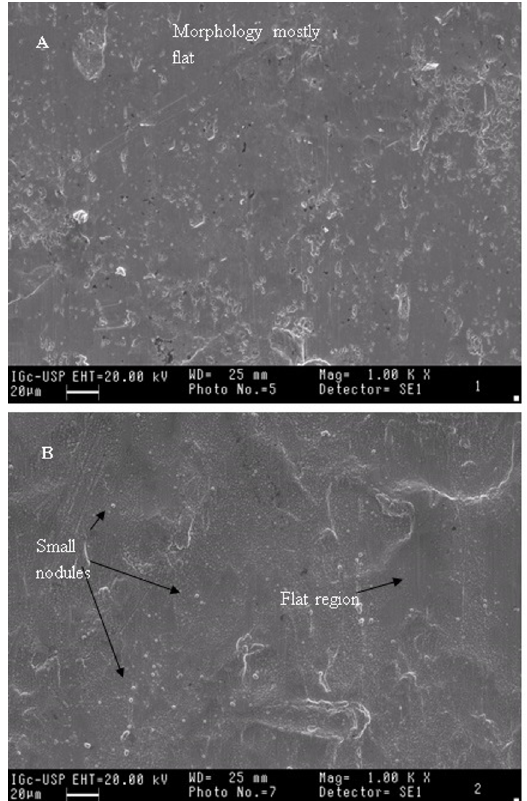
Figure 6. SEM micrographs of the top surfaces of the as-deposited coatings obtained in baths: a) 1 and b) 2.